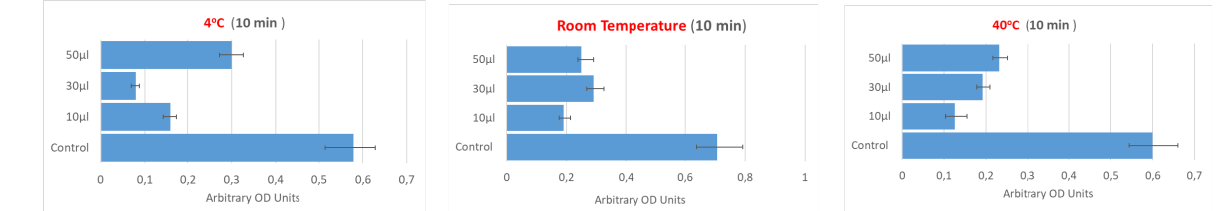
Figure 2. Effect of temperature (4 °C, 25 °C RT, 40 °C), magnetic nanoparticles concentration (10 µ L, 30 μL, 50 μL) and elution time (10 min) on the recovering of commercial astaxanthin. Histograms represent solutions absorbance, for each sample a spectrophotometer measure was performed at 530 nm. Units are presented as OD (Optical Density).